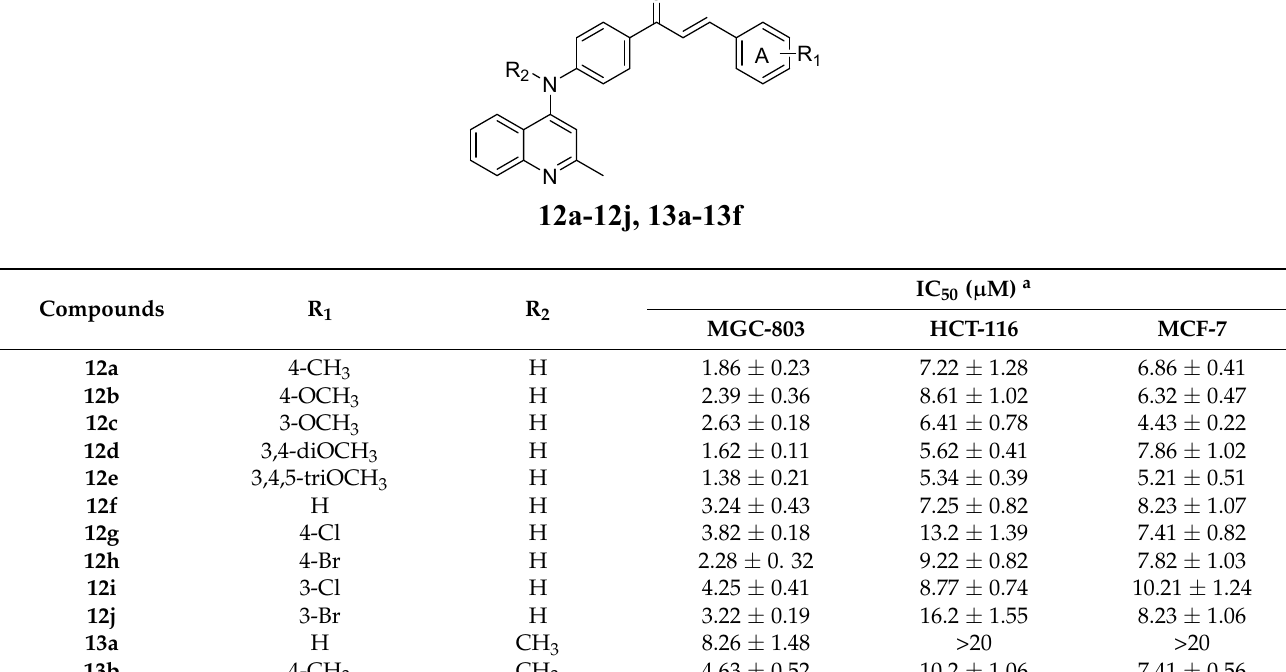
Molecules 2021 , 26 , x FOR PEER REVIEW